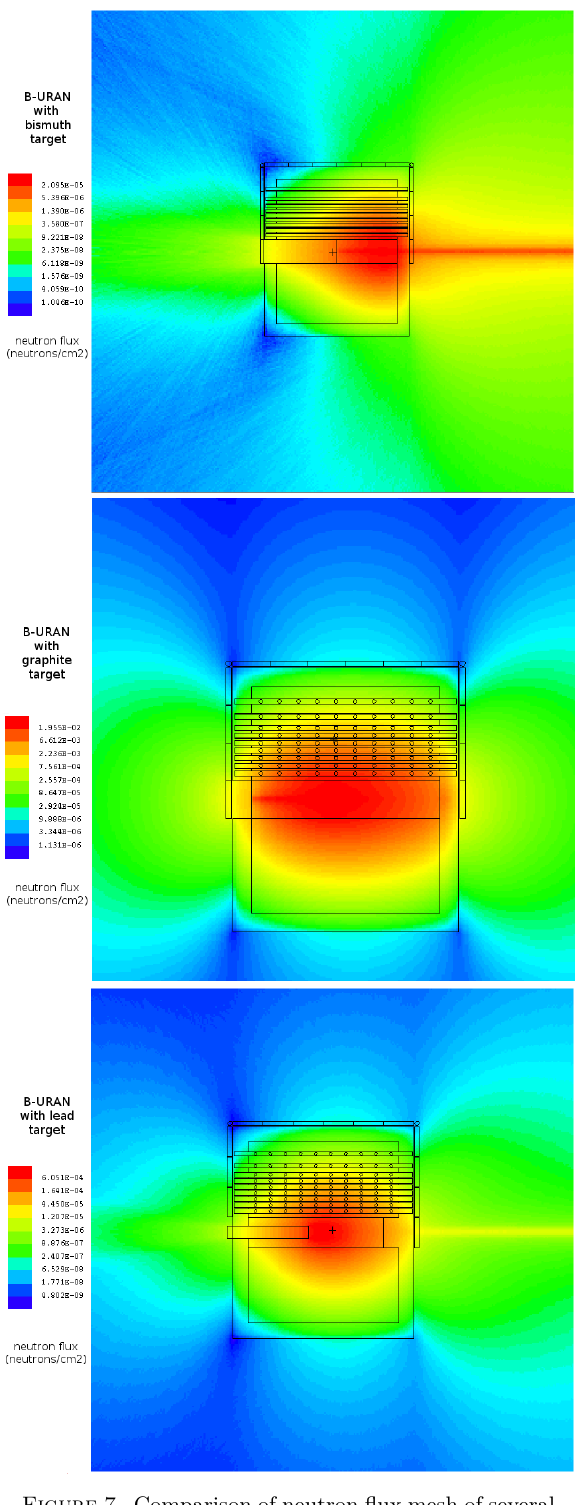
Figure 7. Comparison of neutron flux mesh of several targets (created by MCNP)